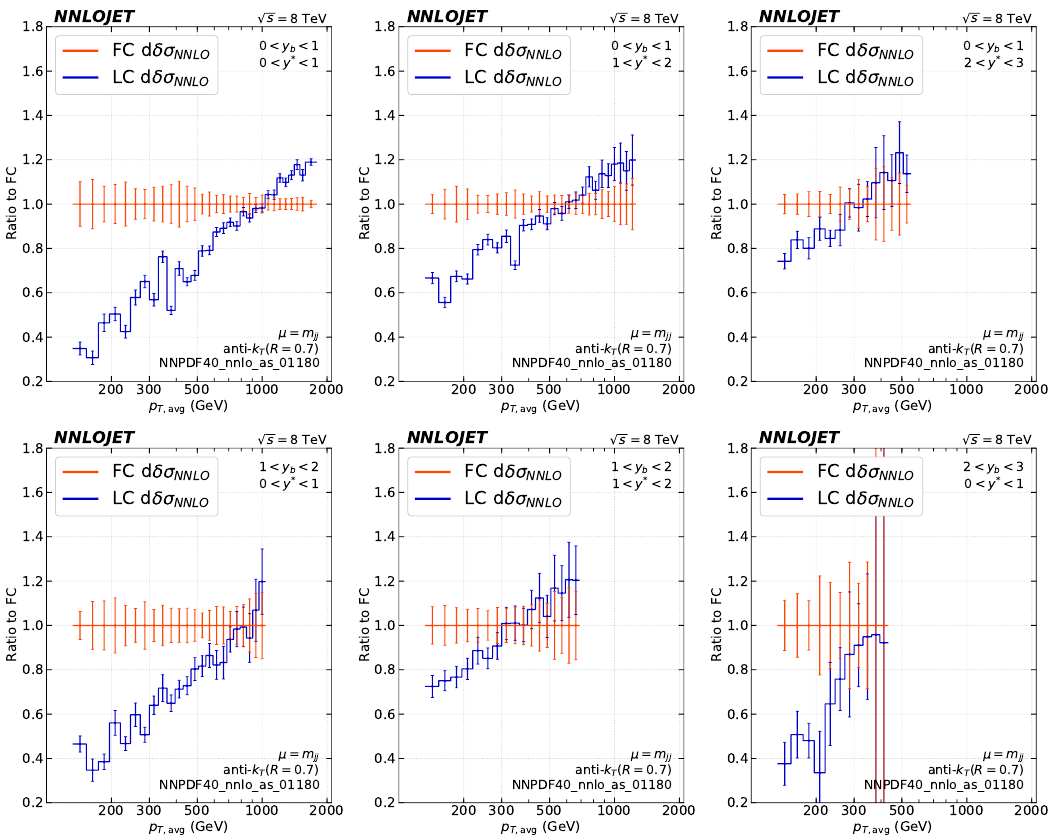
Figure 14 . NNLO coefficient d δσ NNLO at LC (blue) and FC (red) predictions of the triple differ- ential distributions normalized to the FC prediction. Ratios are evaluated at the central scale and error bars represent numerical integration errors